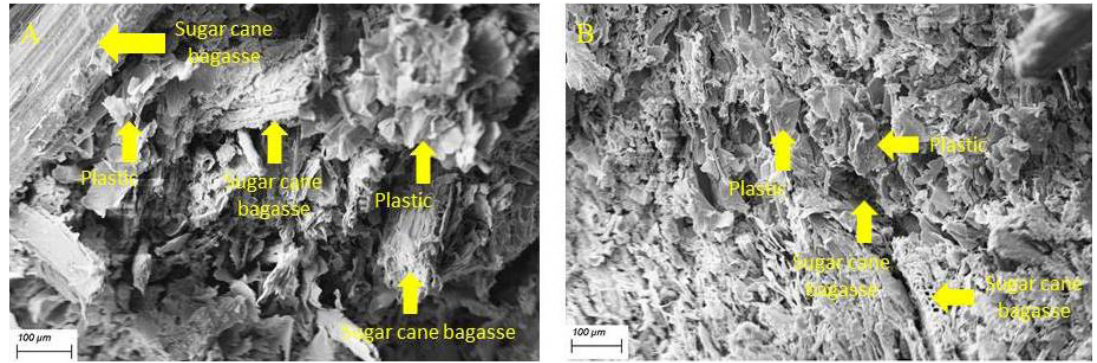
Figure 4. Images obtained by scanning electron microscopy for panels produced at 160°C (A) and 220°C